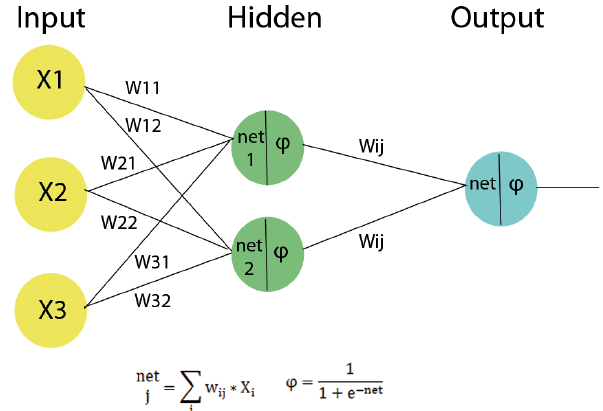
Figure 4. Schematic structure of a feed-forward artificial neural network model and the equations for the integration function netj and the activation function ϕ